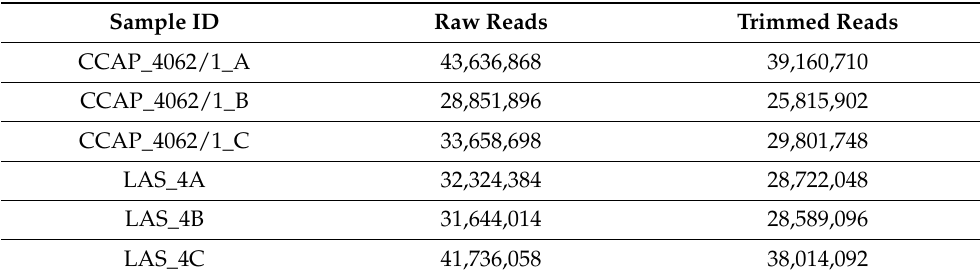
Table A3. Number of reads before and after quality check.